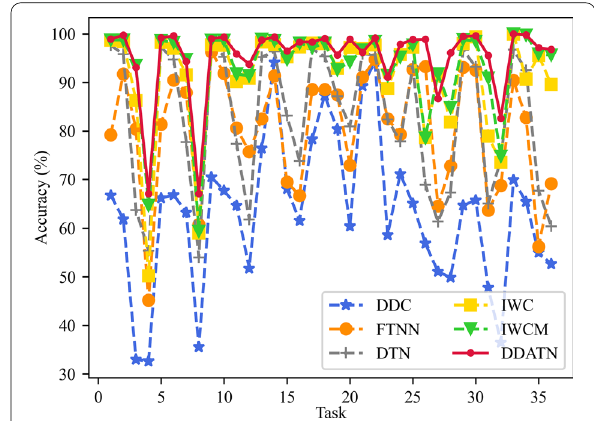
Figure 5 Comparison result